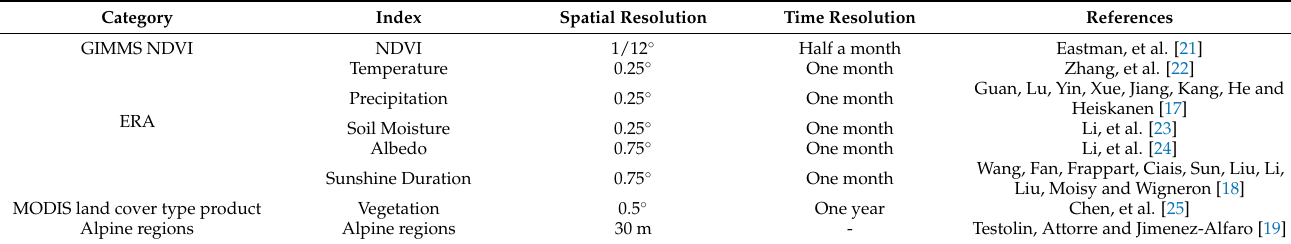
Table 1. Remote sensing vegetation and natural factors data from 1981 to 2015.